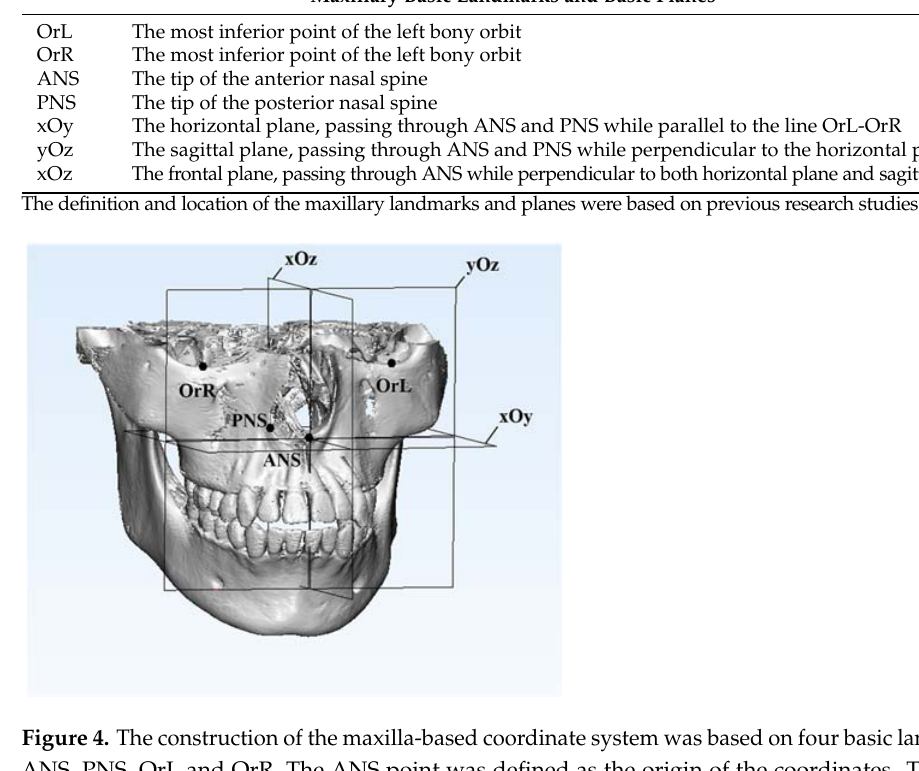
Table 1. Maxillary basic landmarks and planes of the maxilla-based coordinate system.